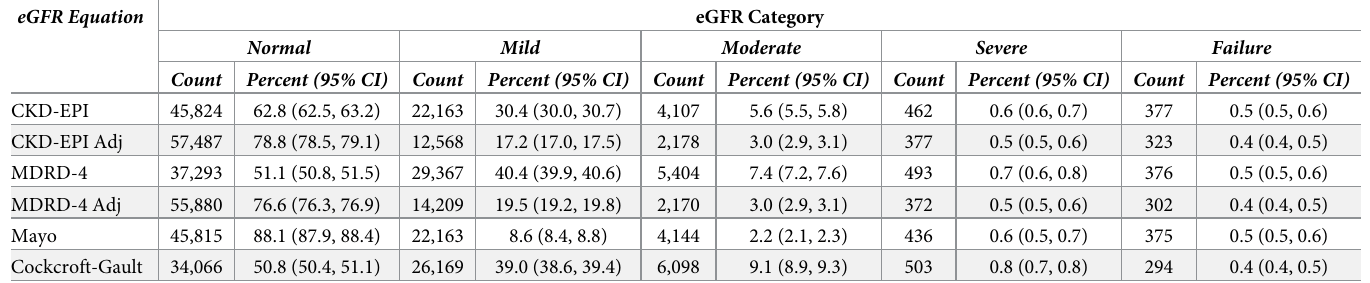
Note: Percent calculated for equation/row; Adj—indicates adjustment for